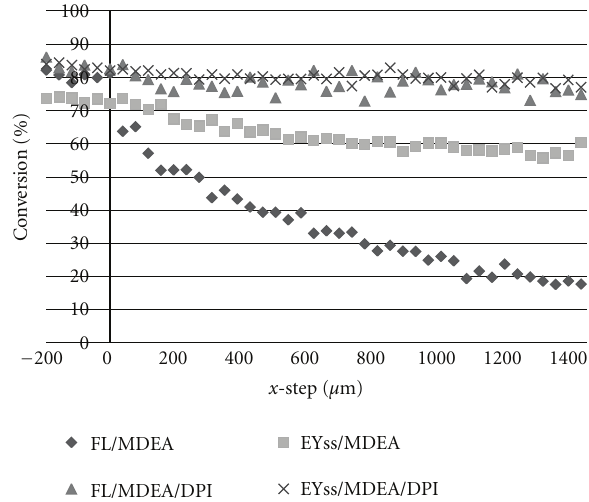
Figure 6: E ff ect of the addition of DPI on the shadow cure conver- sion profiles ( x -direction) observed for FL and EYss dye/amine photoinitiator systems. Light source: a 150 W xenon lamp, light intensity: 89 mW/cm 2 , irradiation time: 15